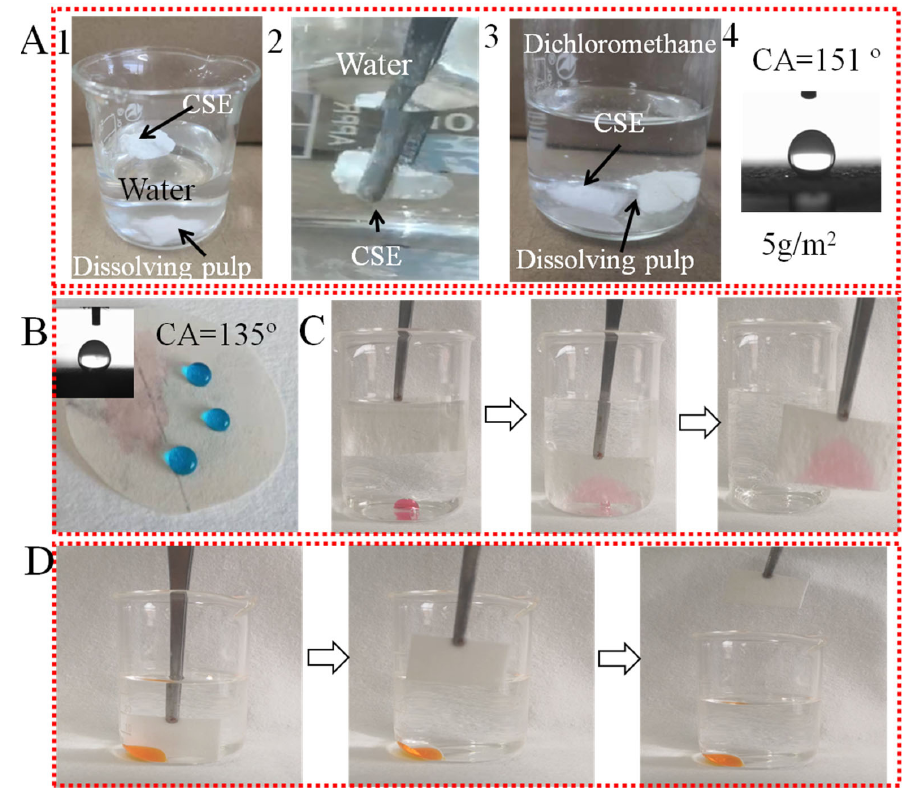
Figure 3. ( A ) Dissolving pulp sunk in water and dichloromethane, CSE floated on water and sank in dichloromethane, and the minimum deposition amount of 5 g/m 2 CSE for superhydrophobicity; ( B ) WCA of OS/CSE@FBP membrane; ( C ) oleophilic in water; ( D ) hydrophobic in oil. The oil and water wettability behaviors of the OS/CSE@FBP membrane are shown in Figure 3B. The membrane was hydrophobic and oleophilic in the air, and the water drop ‐ let stood on the membrane, while the oil spread quickly. The water contact angle meas ‐ ured 135°, which was lower than the contact angle of the CSE, due to the weakening of the hydrophilic OS. As shown in Figure 3C, the membrane adsorbed a small amount of